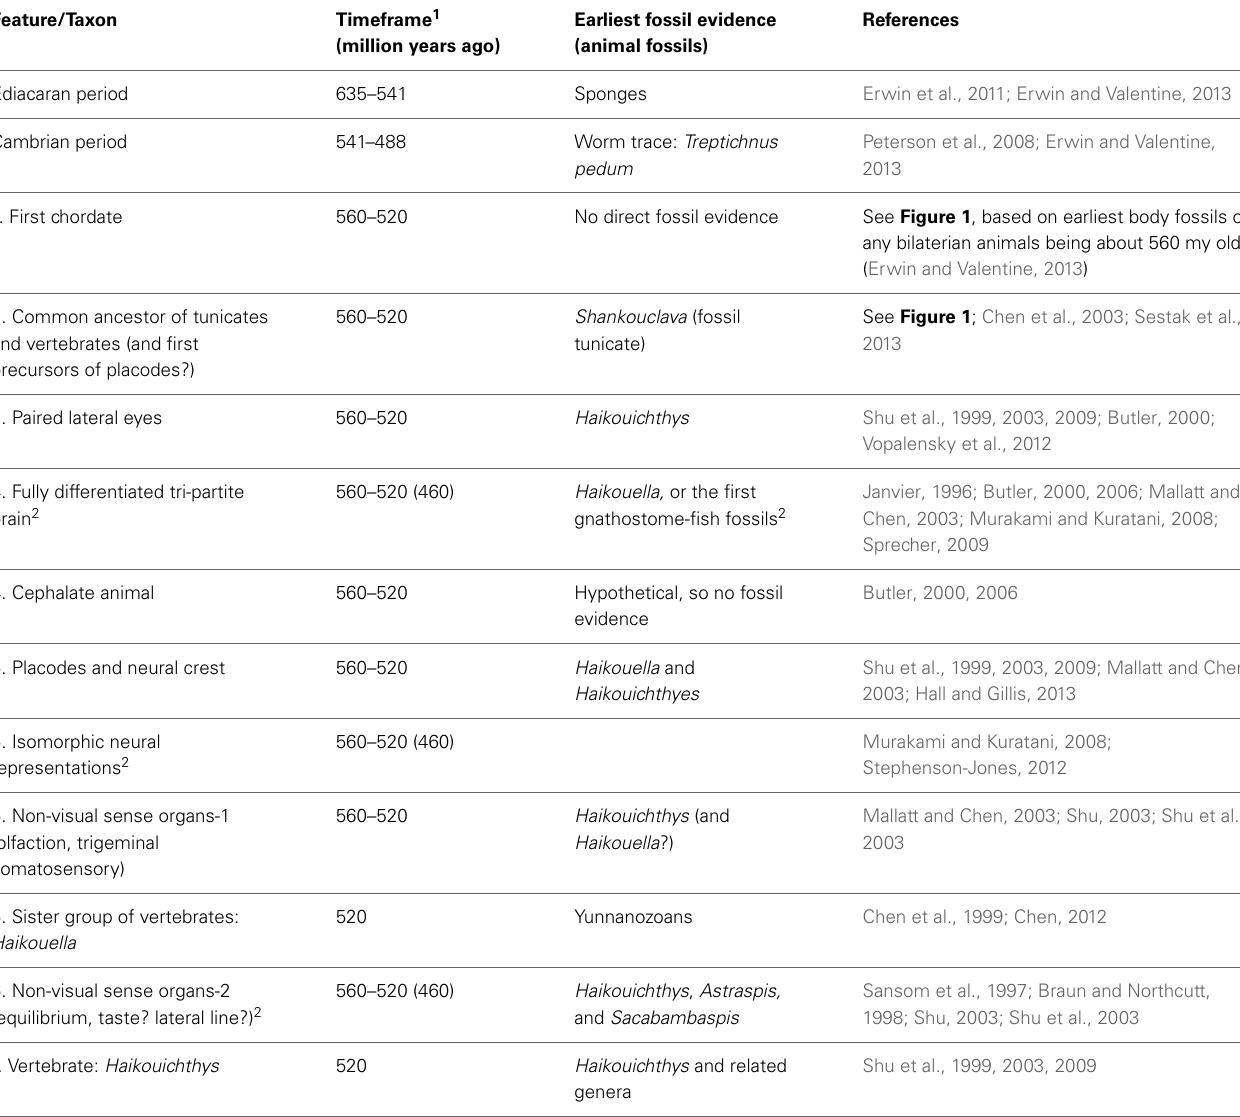
Table 3 | Timeline of the emergence of critical features of sensory consciousness in